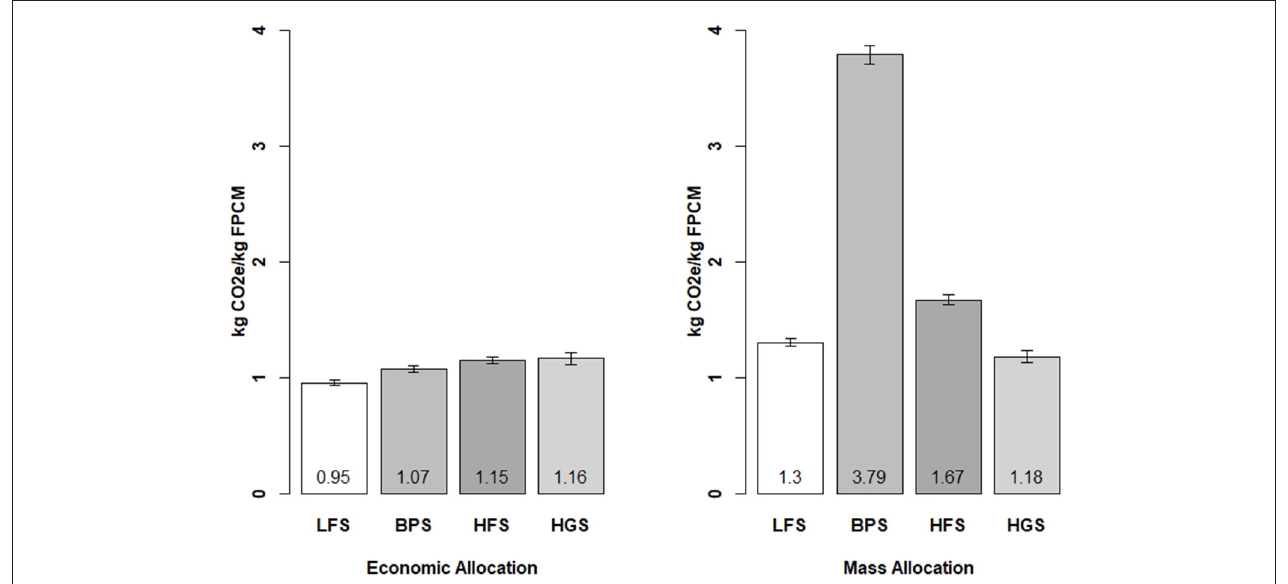
FIGURE 1 | Select merit dairy system average annual footprints per kg of FPCM using Economic and Mass allocation of feed